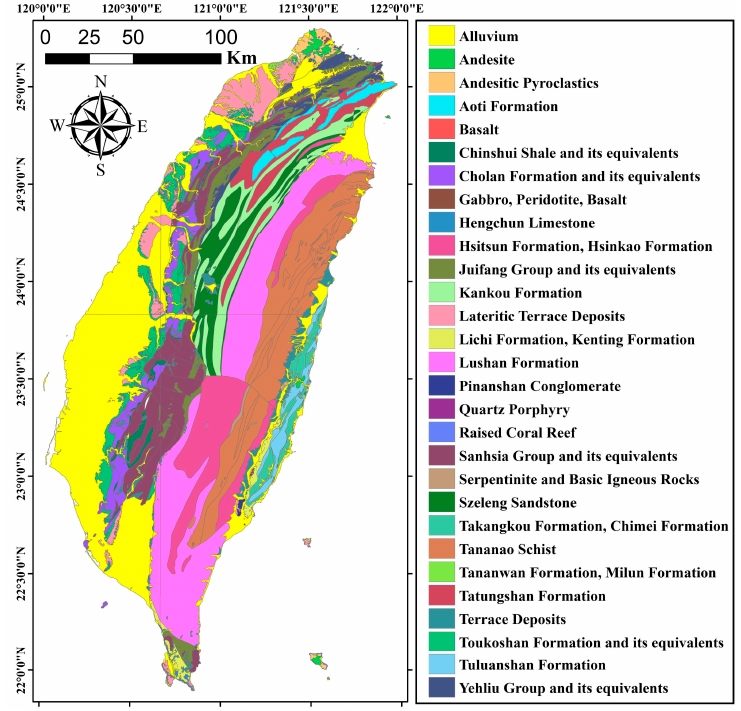
Figure 2. Geological settings in Taiwan (Scale 1:250,000). The flow chart of this research is shown in Figure